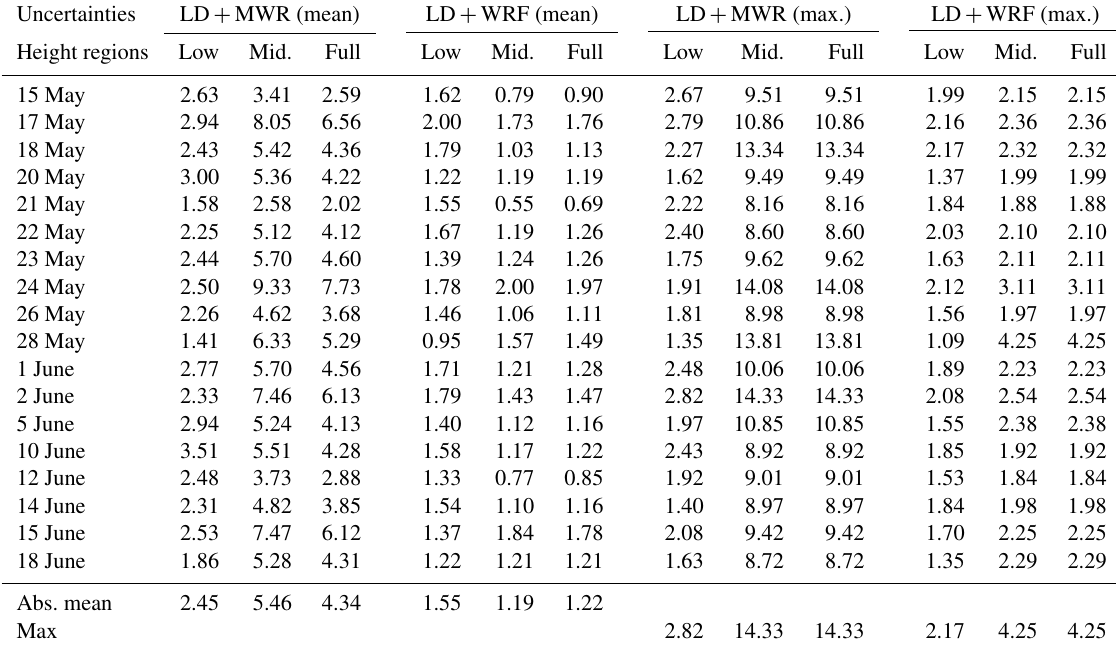
Table 5. Mean and maximum absolute uncertainty of RH synergetic retrieval for two combined methods (lidar–radiometer and lidar–WRF) for different height regions. Data from 25 May are excluded from this analysis due to the signal-to-noise ratio. The lidar system is registered to adequately assess the uncertainties resulting from final RH profiles for this day. Uncertainties LD + MWR (mean) LD + WRF (mean) LD + MWR (max.) LD + WRF